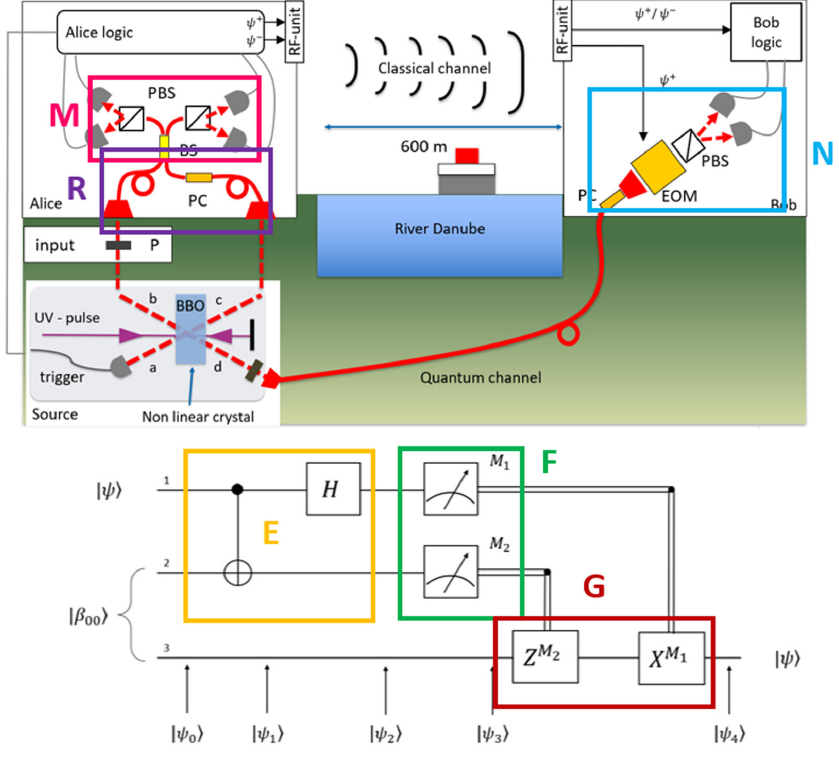
FIG. 22. Experiment and circuit in comparison.